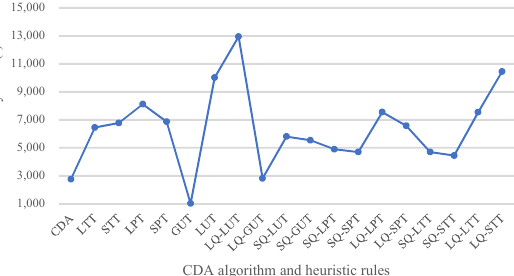
Figure A2. Curve of tasks delay time of CDA algorithm and assignment rules under different cases.